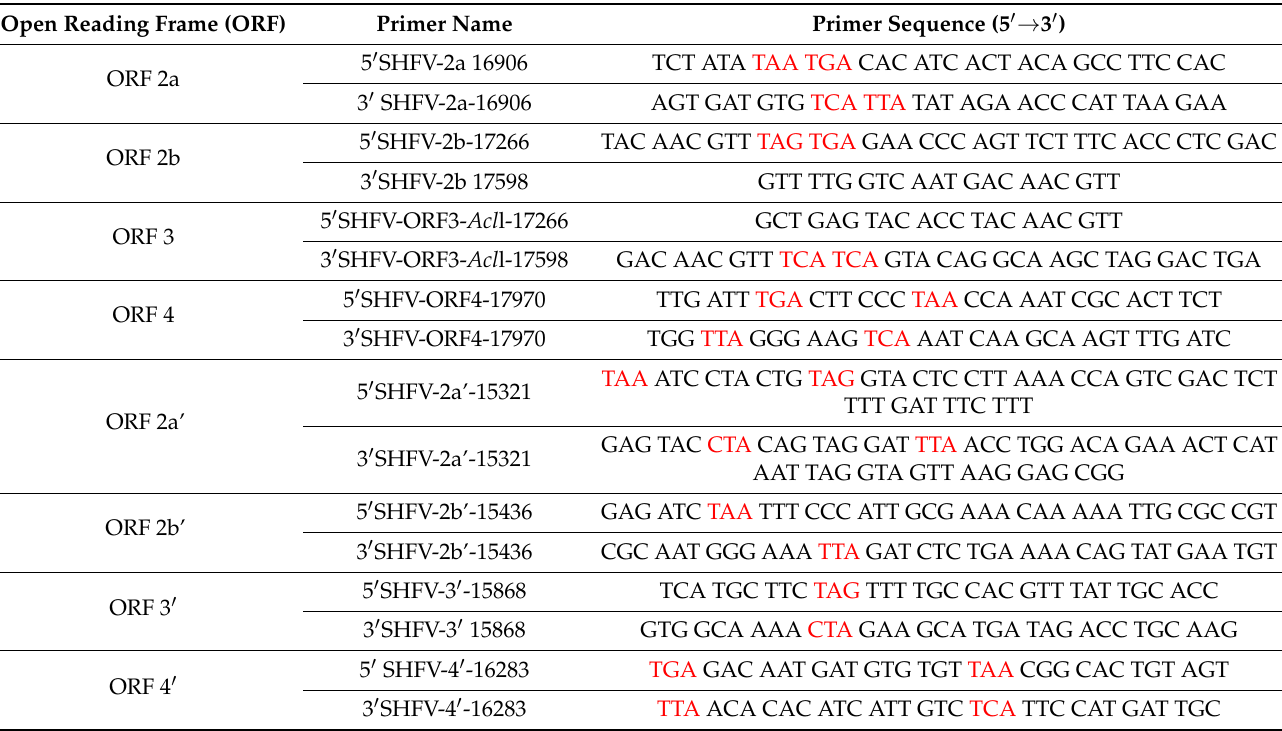
Table 2. Primers used to generate the minor structural protein mutants (introduced stop codons are written in red). Open Reading Frame